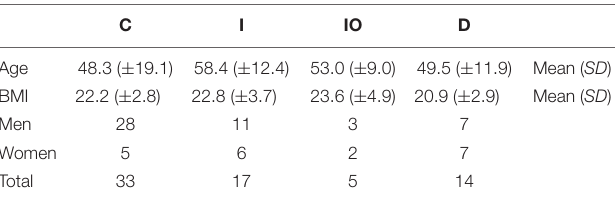
TABLE 1 | Characteristics of subjects in each clinical